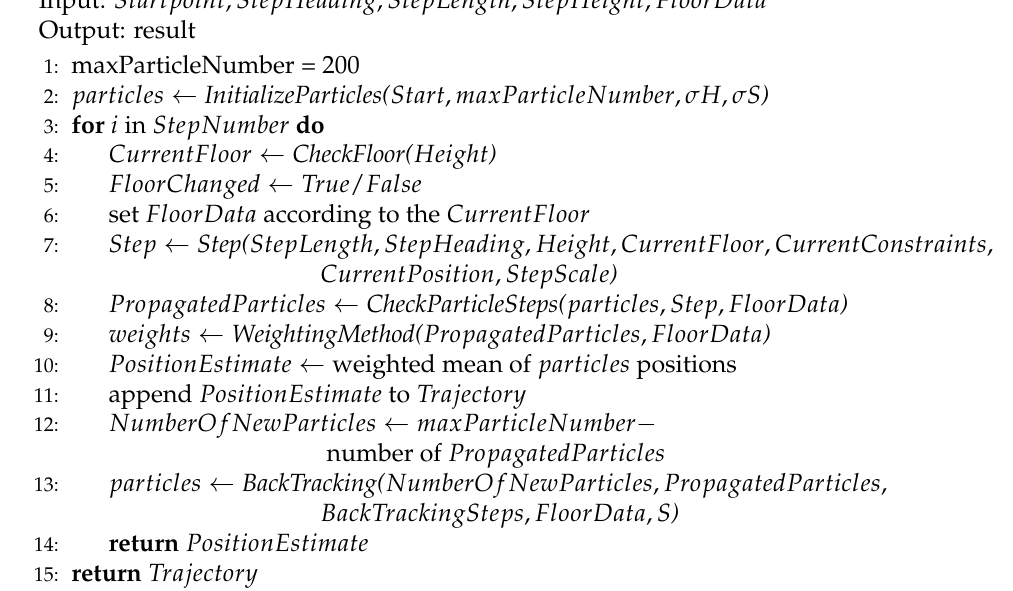
Algorithm 1 Map-matching algorithm with backtracking